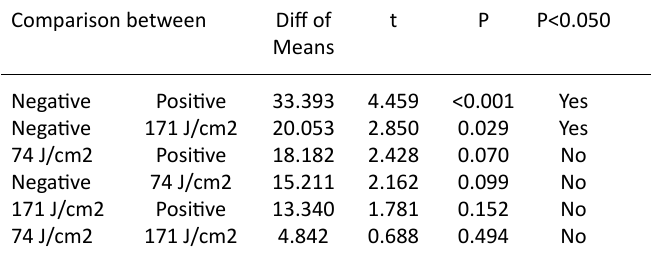
Table 4. Comparison of weight changes in day five Comparison between